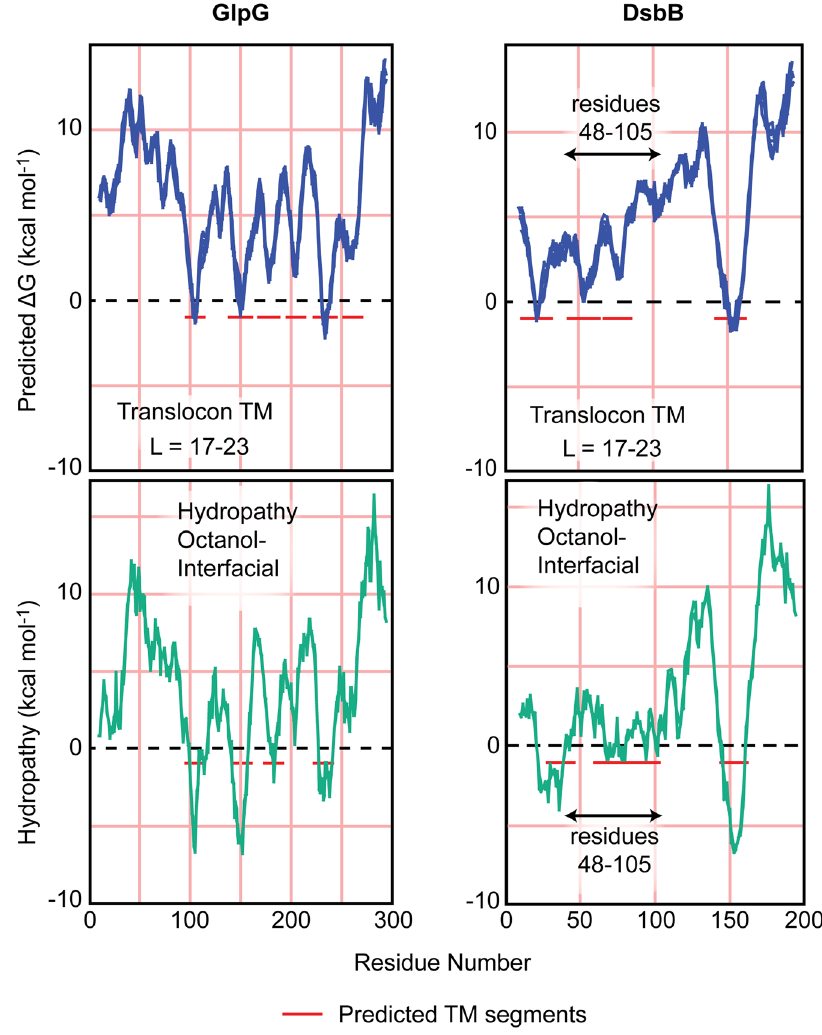
Figure 5. MPEx 46 analysis of DsbB and GlpG. The translocon TM analysis (top row, blue) analyses the TM transfer free energetics based on translocon-mediated TM helix assembly. The Octanol-Interfacial scale (Oct-IF, bottom row, green) identifies segments that tend to prefer a TM helix conformation relative to an unfolded interfacial location. The translocon TM analysis and Oct-IF analysis for GlpG (left) are remarkably similar. The hydropathy analysis for DsbB (right) reveals substantial differences between the translocon TM and Oct-IF analysis, specifically for the polypeptide region (48–105 residues) corresponding to the second and third TM (TM-2 and TM-3,